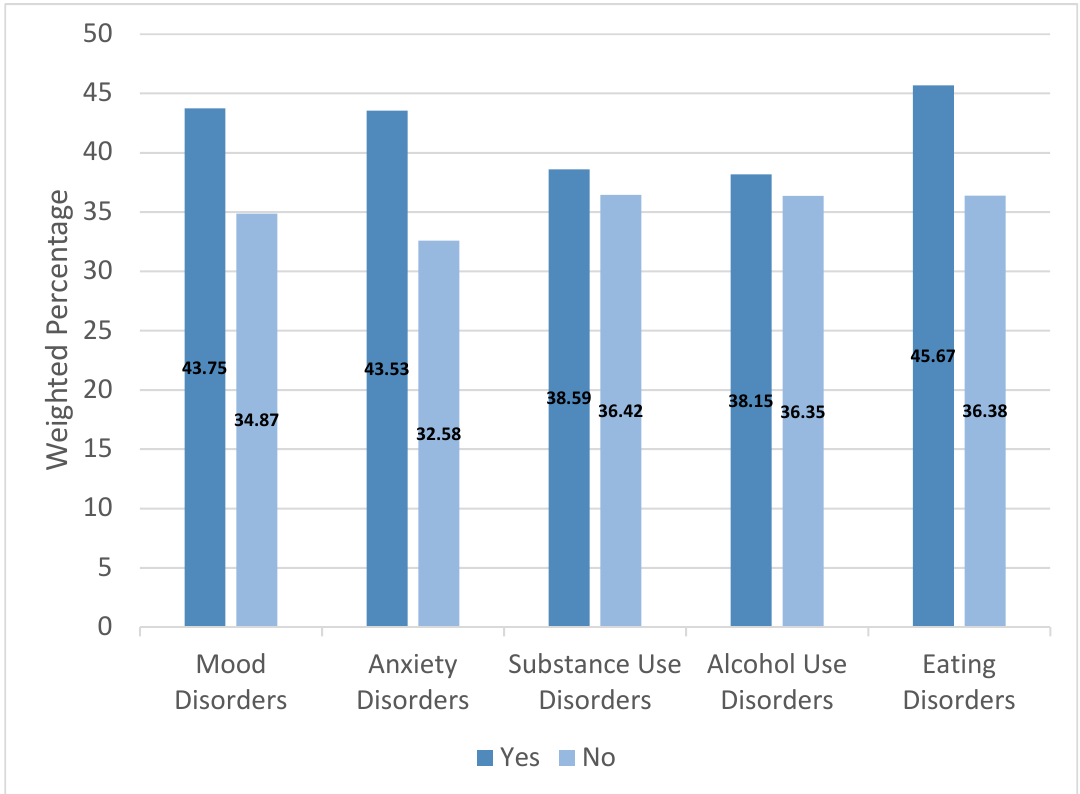
Figure 1. Prevalence of lifetime allergies by lifetime psychiatric disorder (United States, 2001–2003).